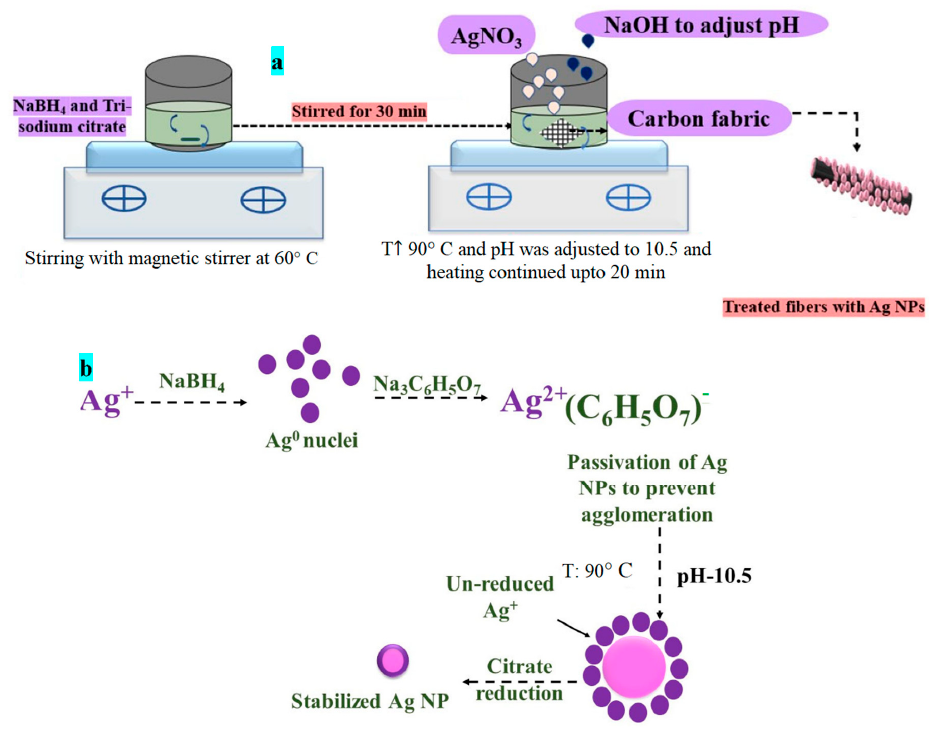
Figure 1. ( a ) Schematic for the process and ( b ) in situ growth of Ag-NPs -mechanism